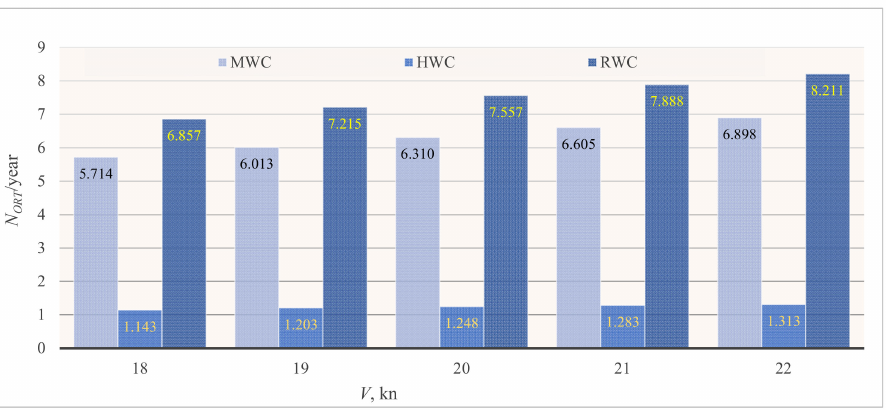
Figure 21. The number of round trips per year for MW, HW, and RW depending on the sailing speed.